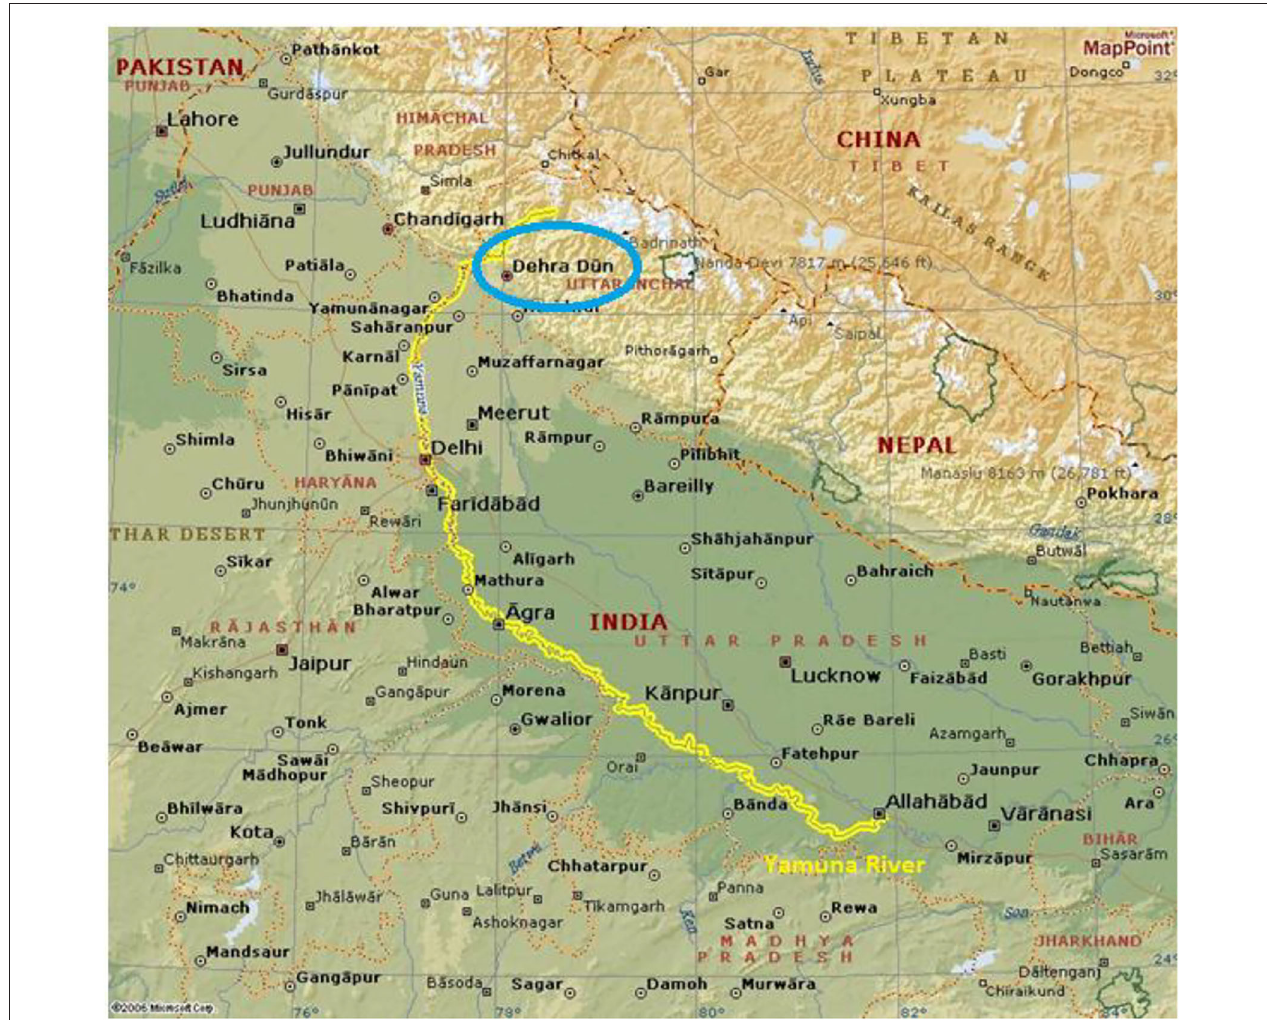
FIGURE 2 | Map for considering location for Yamuna, Dehradun (https://www.bcmtouring.com/forums/thread).